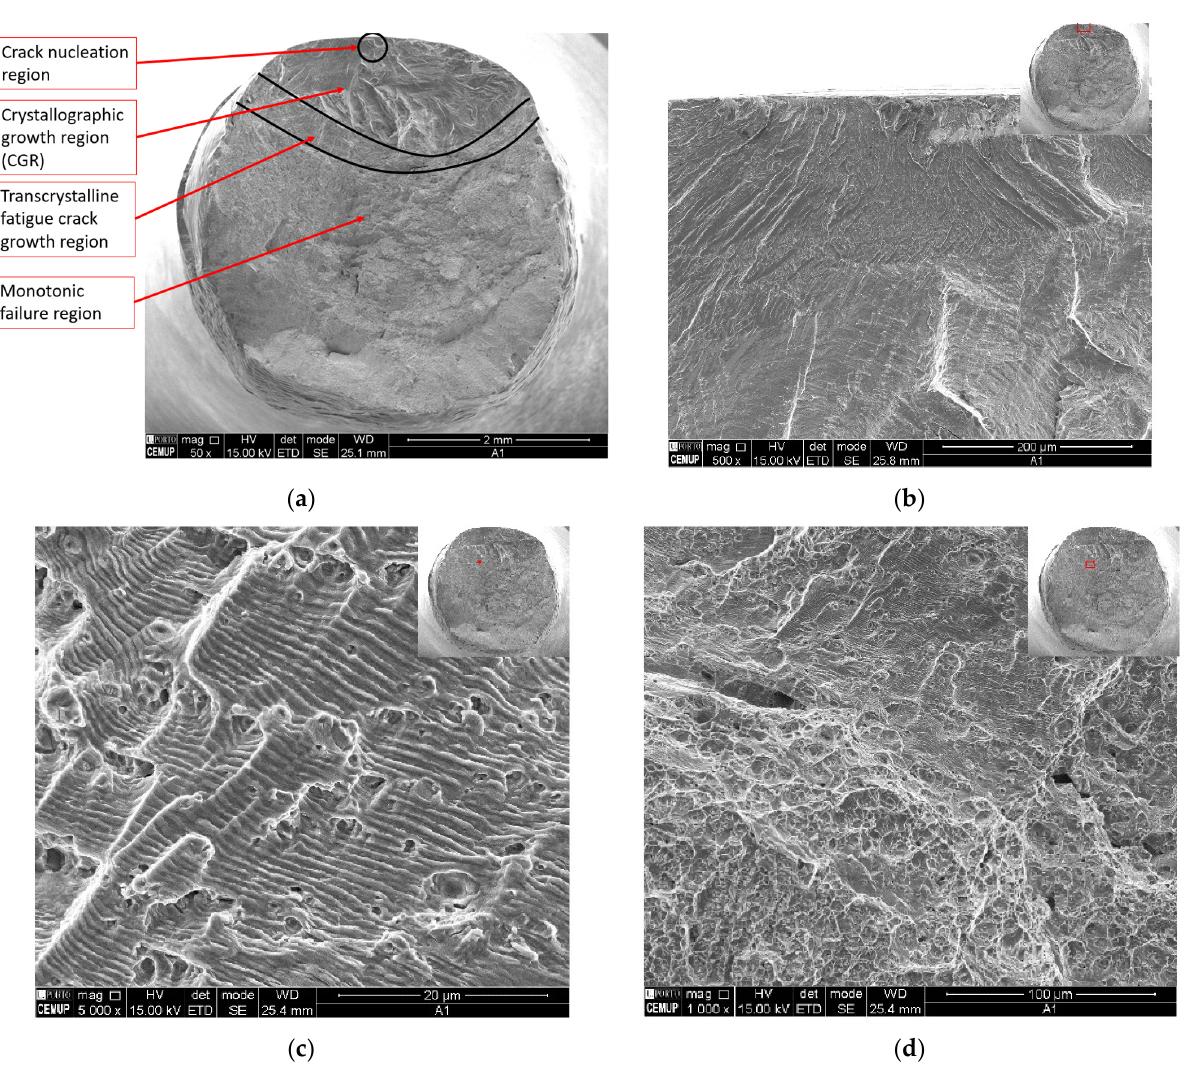
Figure 17. Fracture surfaces for standard axial fatigue specimen, sample A1, maximum stress = 777 MPa: ( a ) Fracture surface overview; ( b ) Crack nucleation region; ( c ) Transcrystalline fatigue crack growth region; ( d ) Interface between fatigue and monotonic failure.